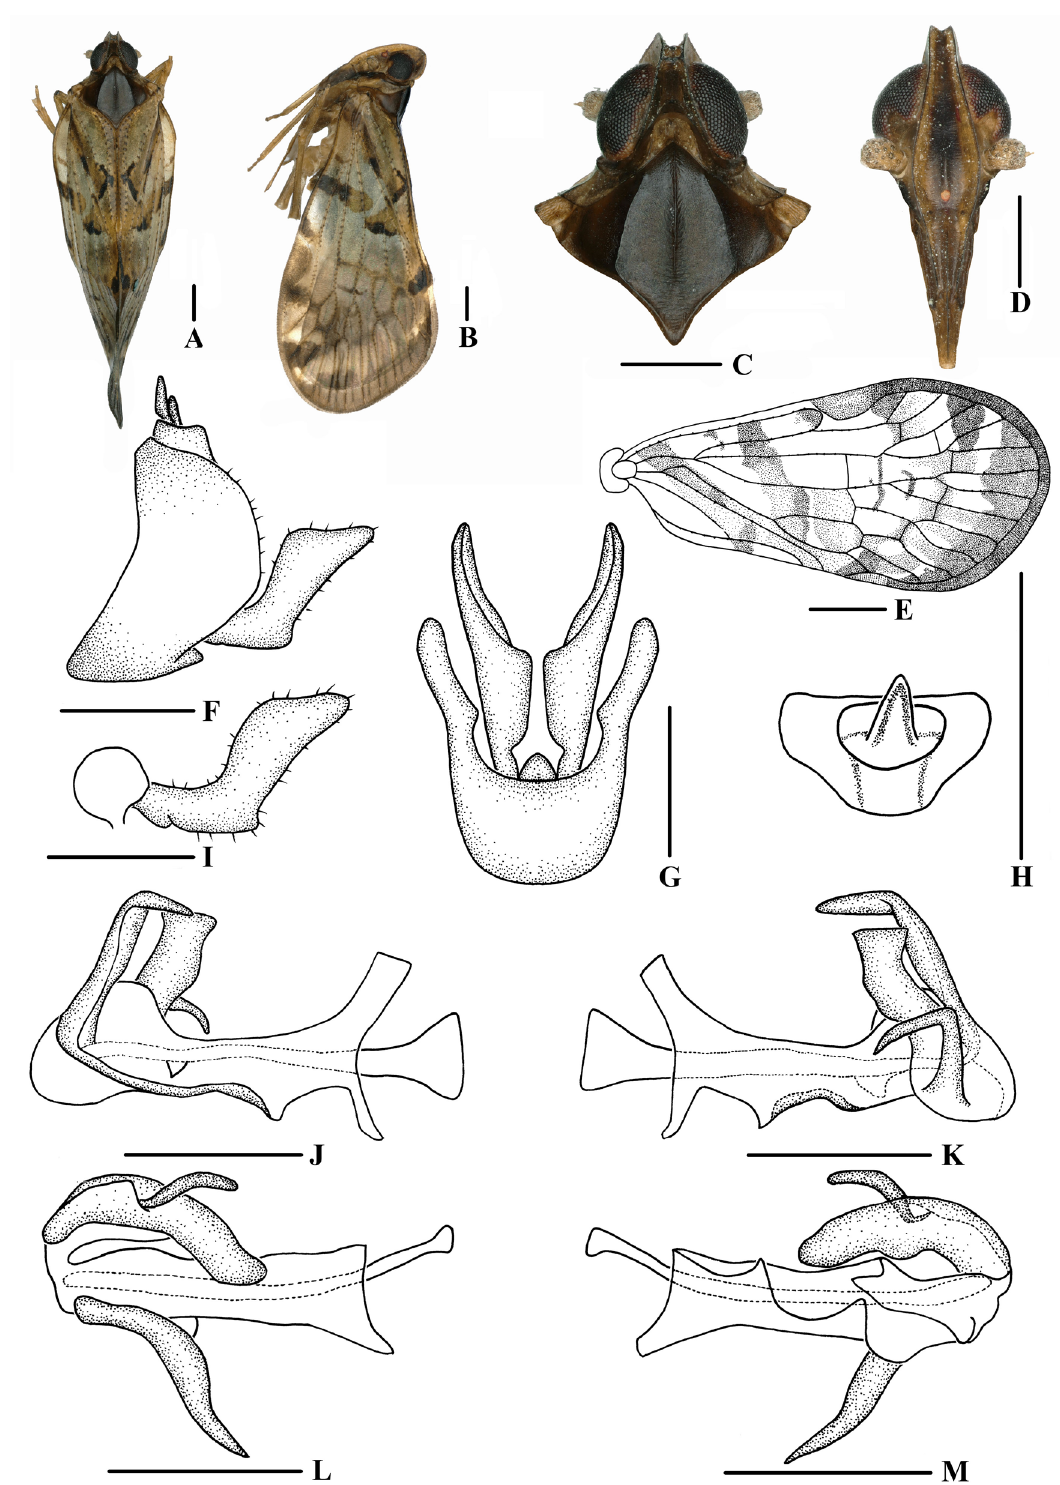
Fig. 7. Andes latanalus Wang & Chen sp. nov., ♂. A . Dorsal view. B . Lateral view. C . Head and thorax, dorsal view. D . Face, ventral view. E . Forewing. F . Genitalia, lateral view. G . Pygofer and gonostyli, ventral view. H . Anal segment, dorsal view. I . Gonostyli, lateral view. J . Aedeagus, right side. K . Aedeagus, left side. L . Aedeagus, dorsal view. M . Aedeagus, ventral view. Scale bars: A–D, F–M = 0.5 mm; E = 1.0